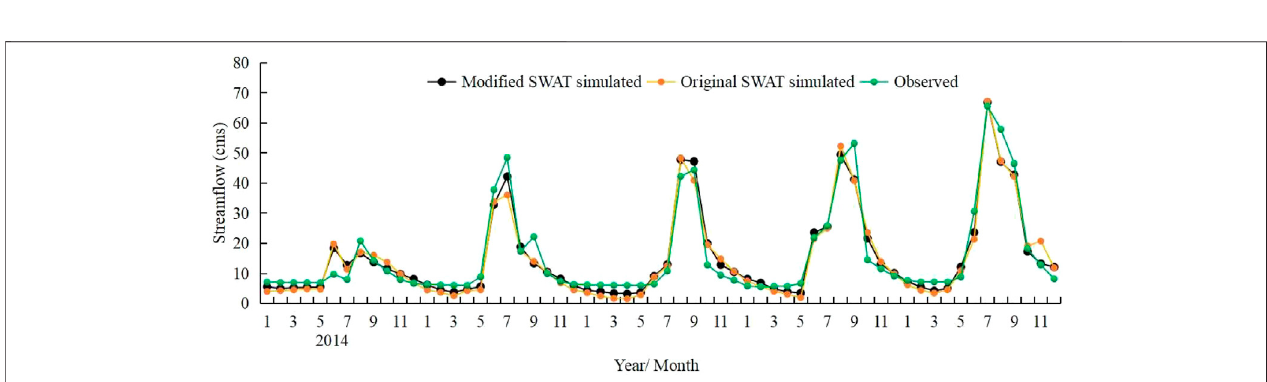
FIGURE 8 | The monthly stream fl ow simulated by the original and modi fi ed Soil and Water Assessment Tool (SWAT) models compared to the that of observed stream fl ow.